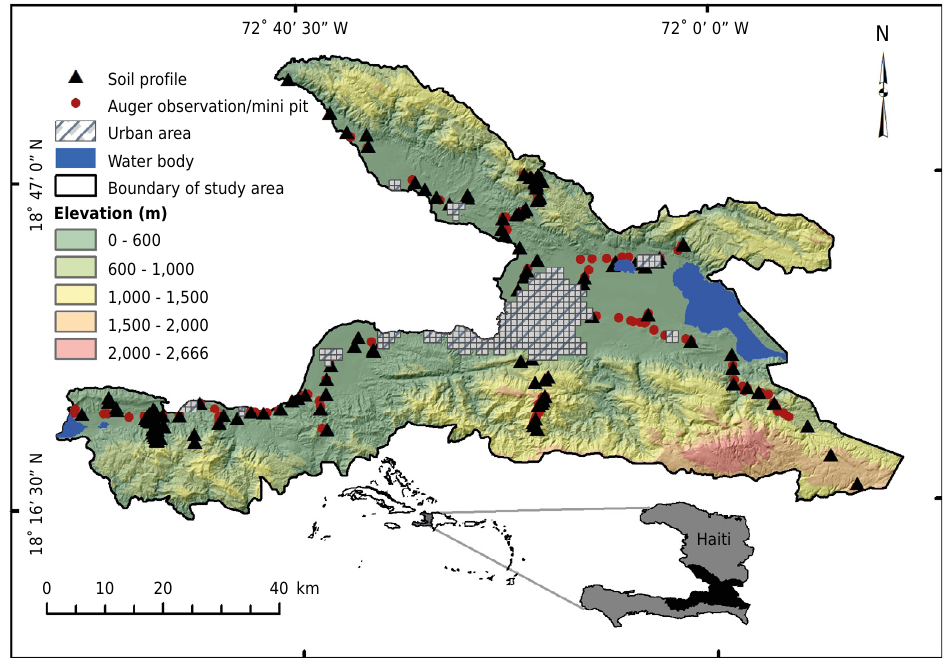
Figure 1. Spatial distribution of the soil pits described and sampled in western Haiti,